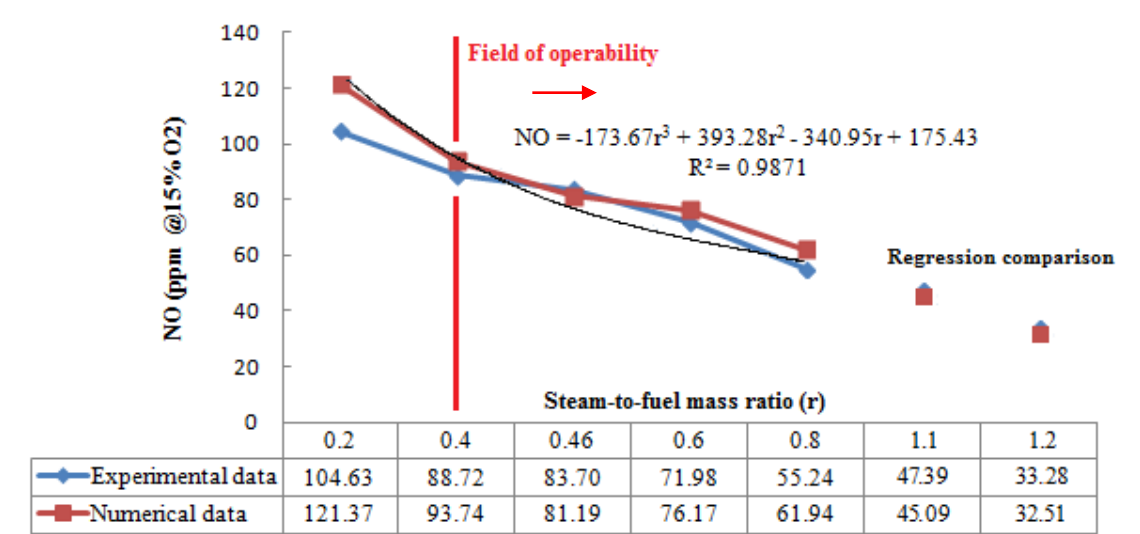
Figure 6. NO emission vs . steam-to-fuel mass x